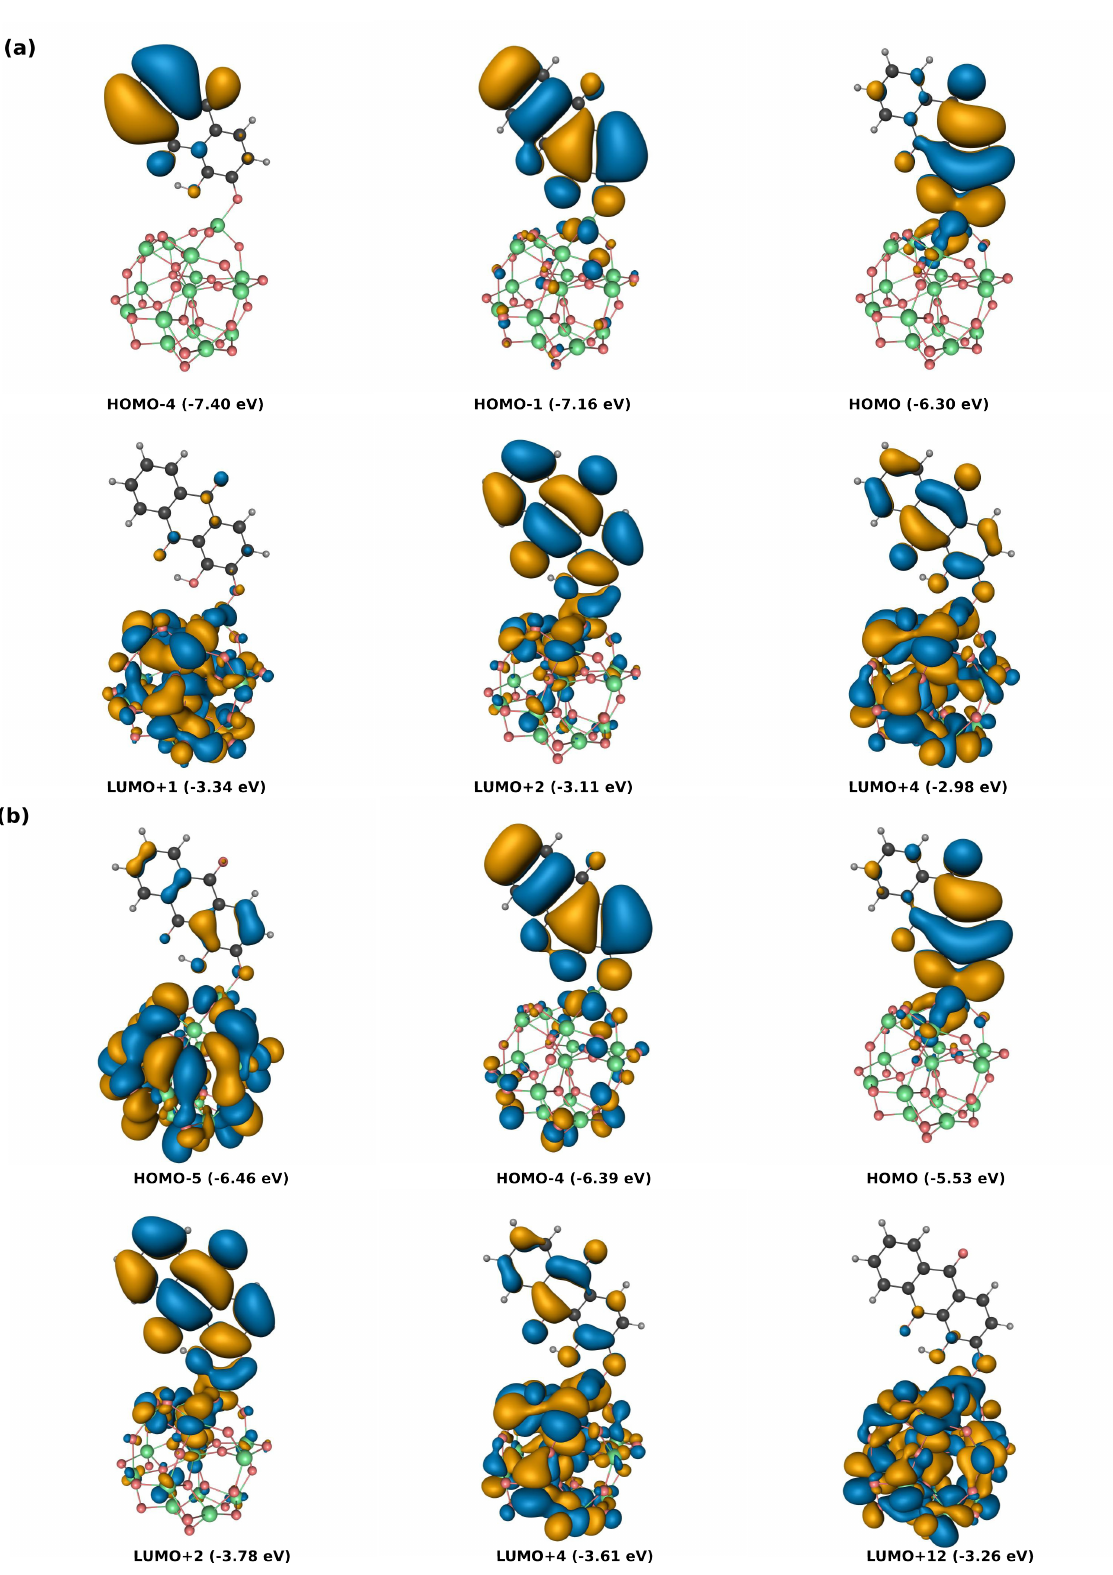
Figure 3. Dominant molecular orbital contributions to the excitations of selected low energy bands in the alizarin-(TiO ) complex obtained using ( a ) B3LYP and ( b ) PBE. Isosurface 2 15 − 3 value is set to 0 . 0675 Å